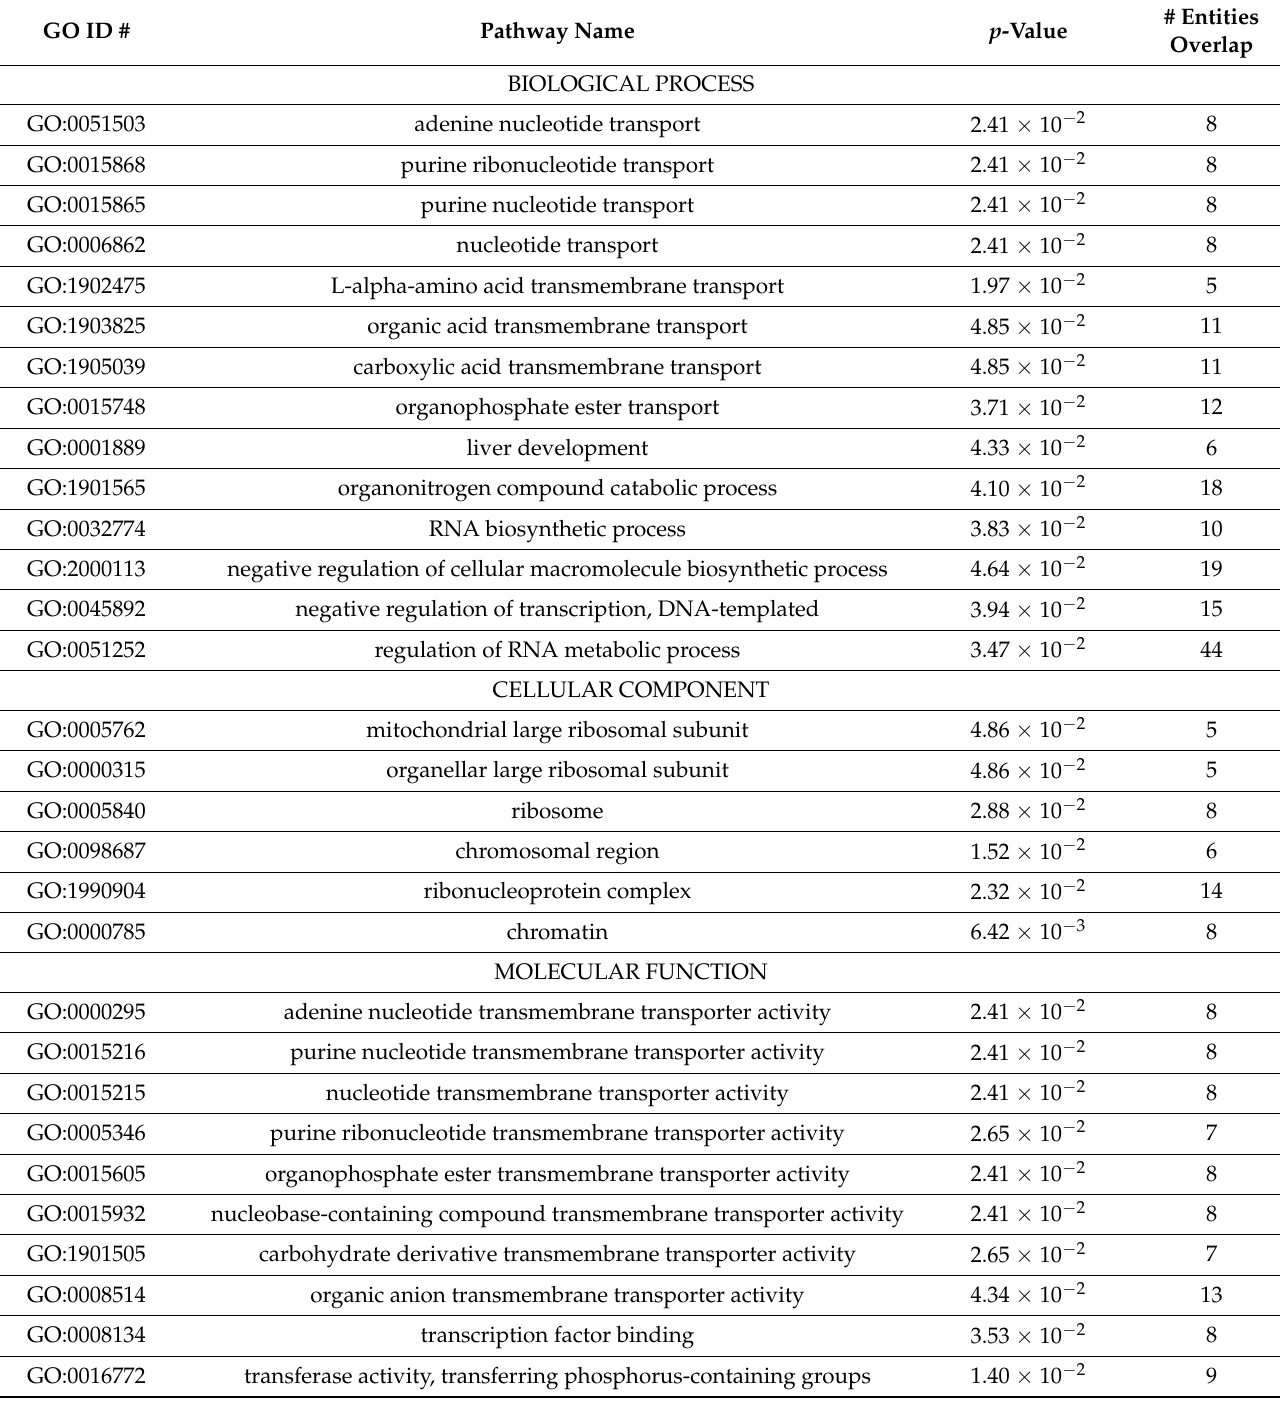
Table 1. GSEA identified GO pathways enriched with the A β 42 proteome data